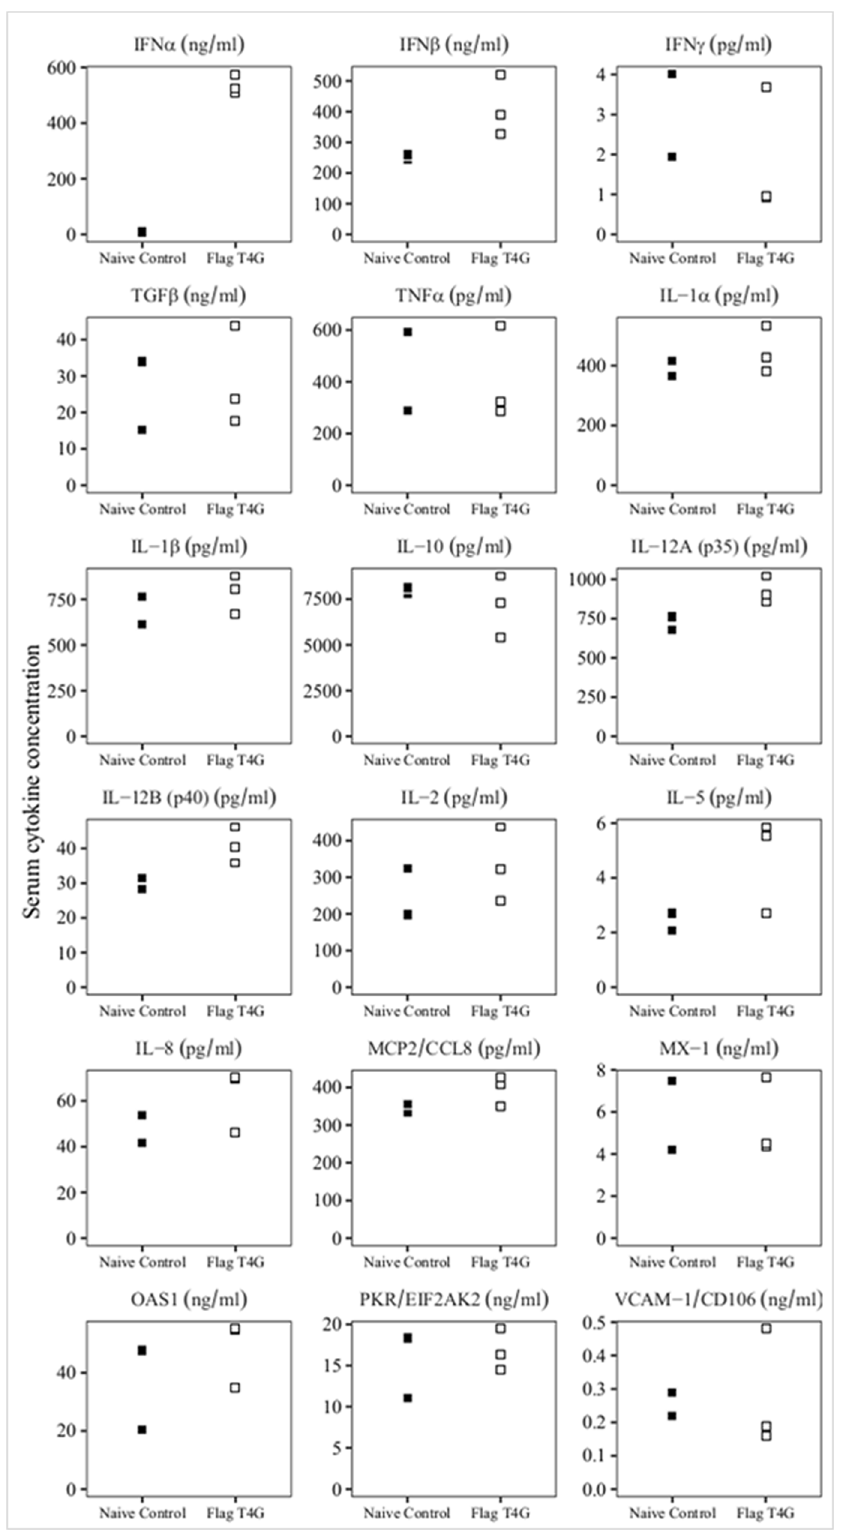
Fig 5. Evaluation of the systemiclevels of different host cytokines in swine. Samples were taken on the third day after inoculationwith FlagT4G virus (FlagT4Gv), or mock infection(na ï vecontrol). Data represent